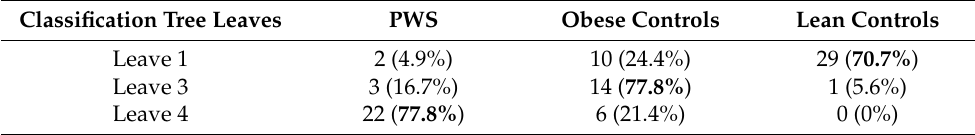
Table 3. Contingency table of Classification Tree Leaves by subject group. Classification Tree